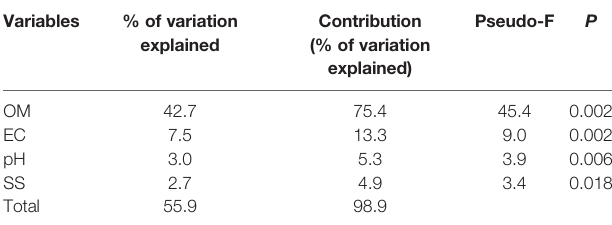
TABLE 2 | Results of redundancy analysis (RDA) of element concentrations constrained by environmental variables, OM, soil organic matter; SS, soil salinity; pH and EC, electrical conductivity; determined by interactive forward selection procedure with unrestricted permutation tests, combining all sites (21) and all replications (3 for each site), therefore